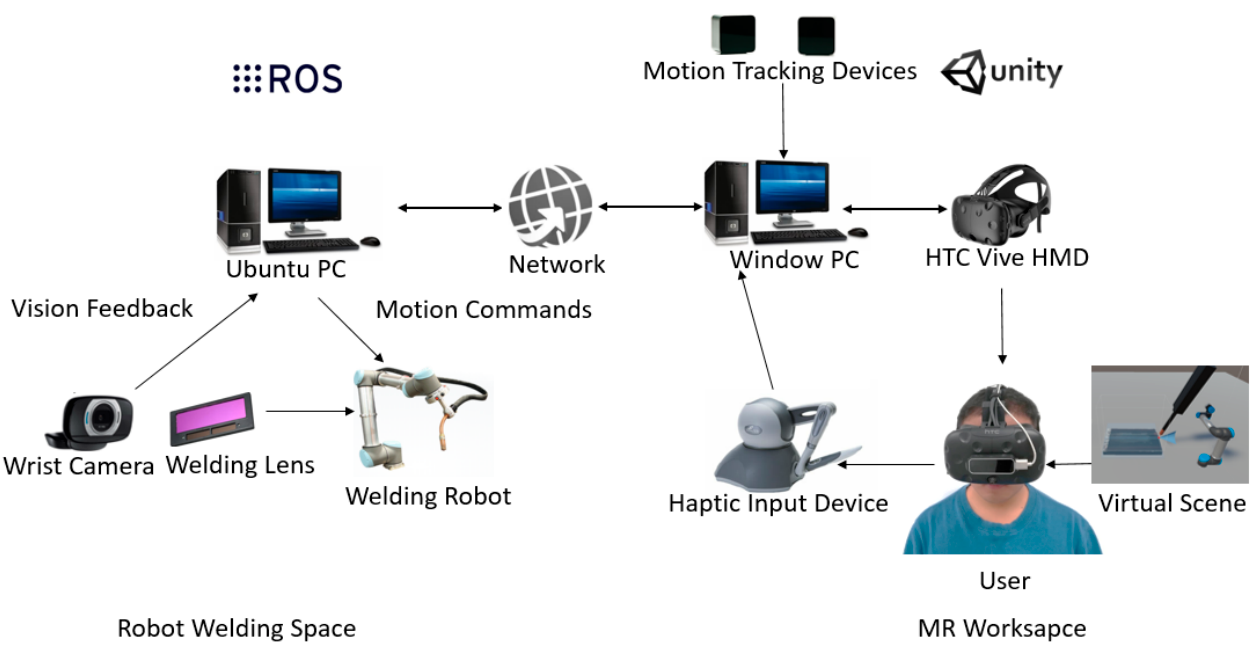
Figure 2. The communication scheme of the MRVF tele-welding hardware apparatus.